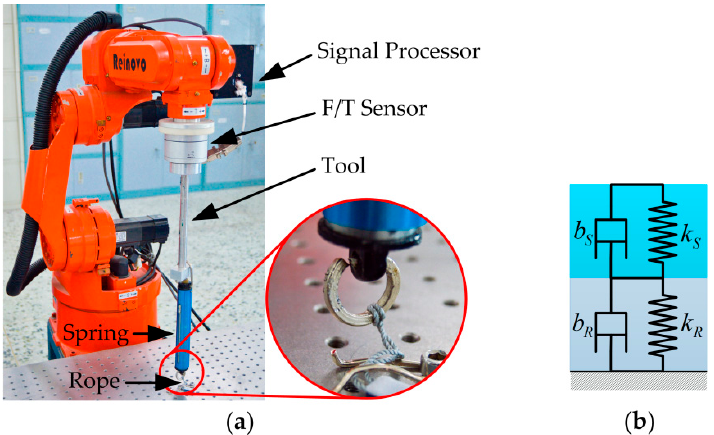
Figure 14. ( a ) Experimental setup; ( b ) simplified model of the contact environment.